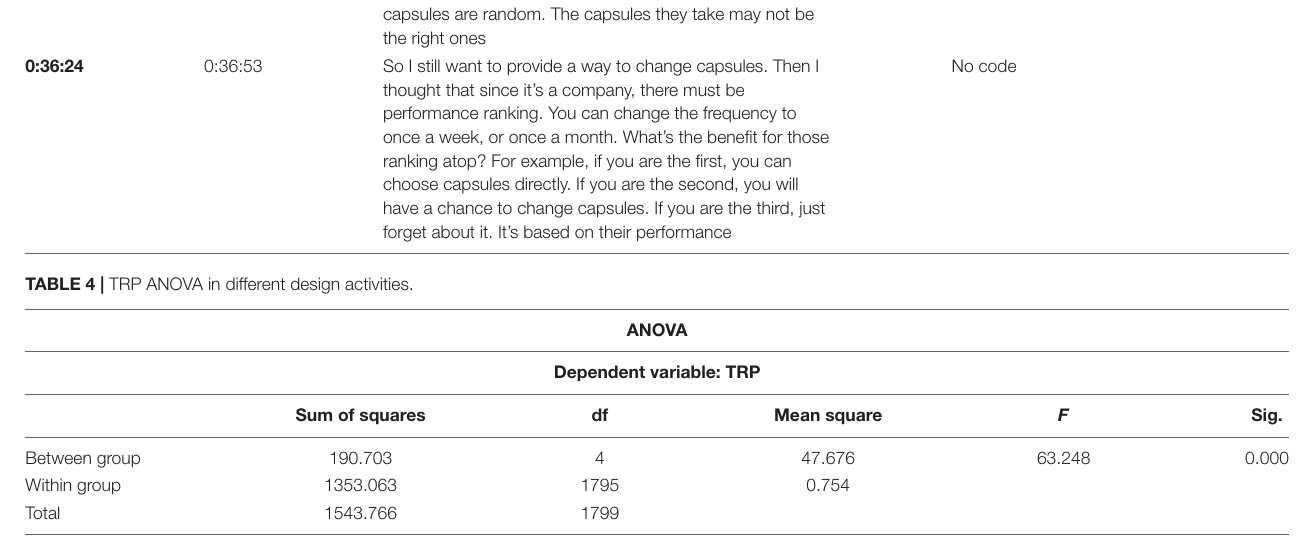
TABLE 5 | TRP ANOVA in different brain